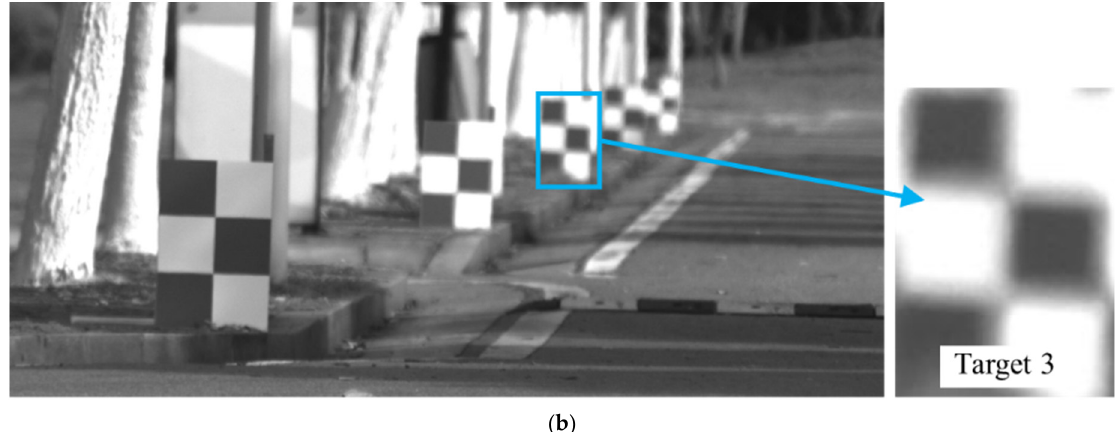
Figure 13. A comparison of the imaging results between the Scheimpflug camera and the conventional camera. ( a ) The imaging result of the Scheimpflug camera. ( b ) The imaging result of the conventional camera.